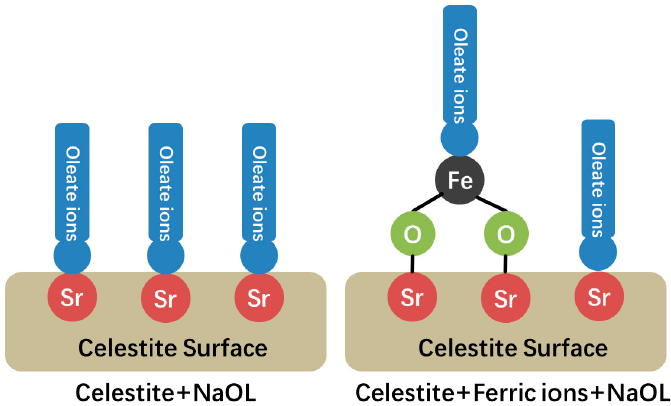
Figure 16. Schematic representation of the depression mechanism of ferric ion adsorption on celestite flotation.